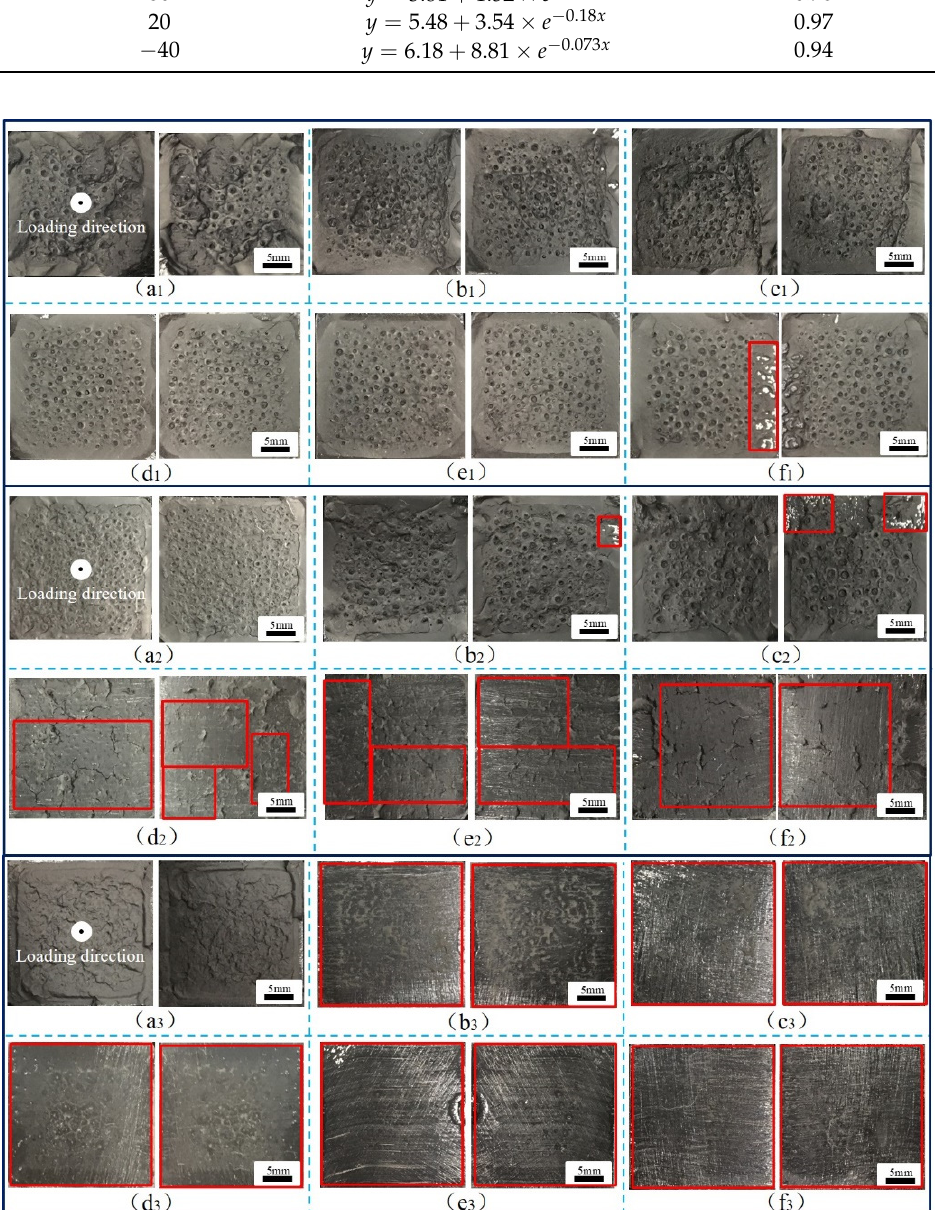
Figure 12. BJs, high temperature: ( a 1 ) 0, ( b 1 ) 6, ( c 1 ) 12, ( d 1 ) 18, ( e 1 ) 24, ( f 1 ) 30 days;